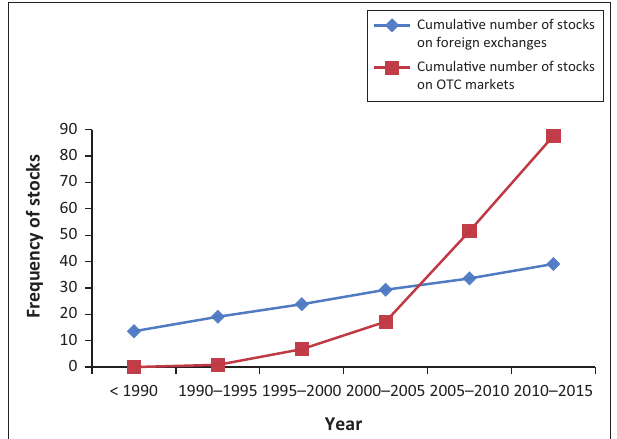
FIGURE 1: Cumulative number of internationalised shares in South